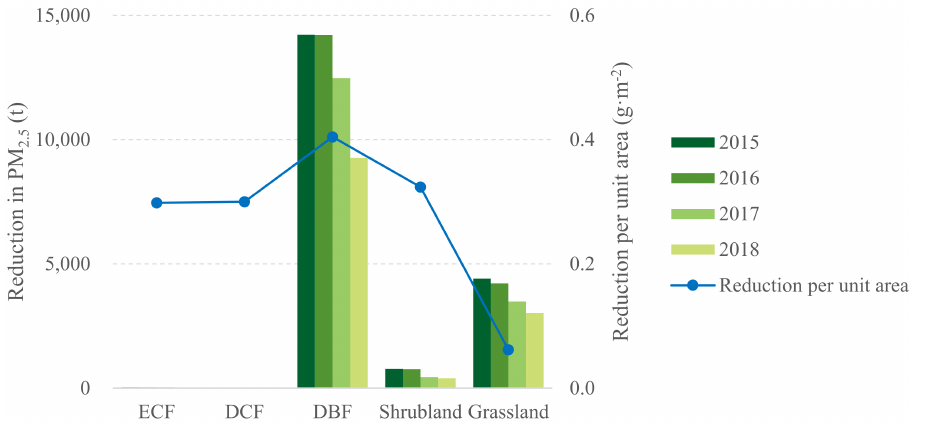
Figure 11. PM 2.5 removal of each month at the overall scale from 2015 to 2018.